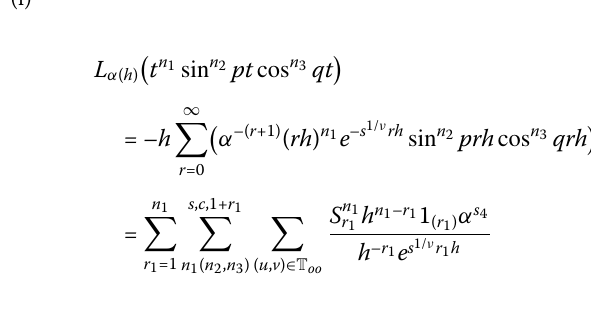
for (cid:5) = 0.3 and varying α . Figure 3 shows the output signal for (cid:5) = 0.5 with varying α . Figure 4 is the output signal for (cid:5) = 0.8 with varying α